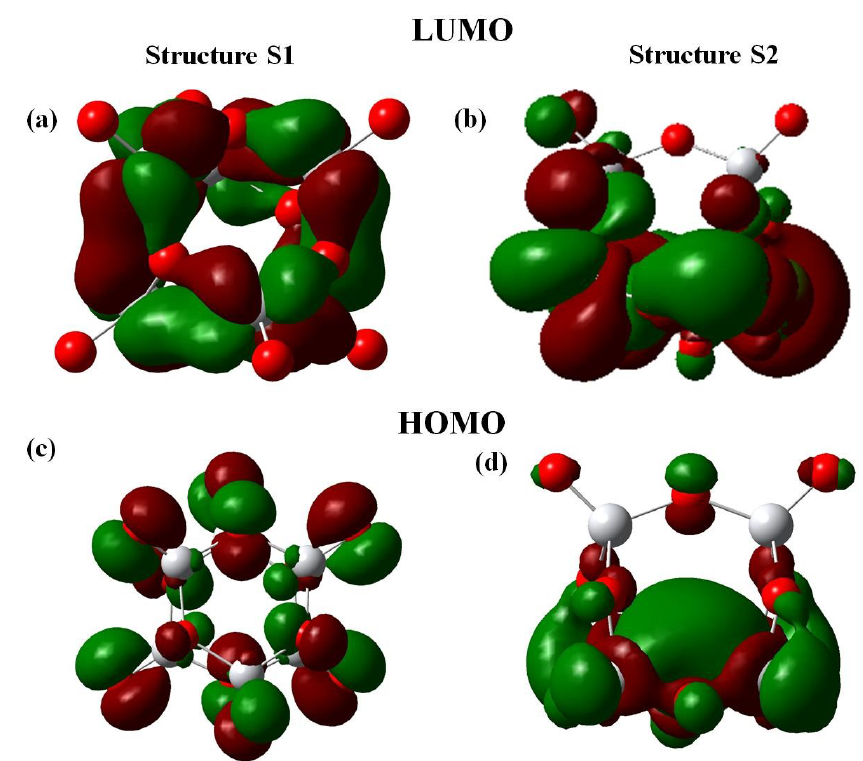
Figure 5. The frontier molecular orbitals of the clusters S1 and